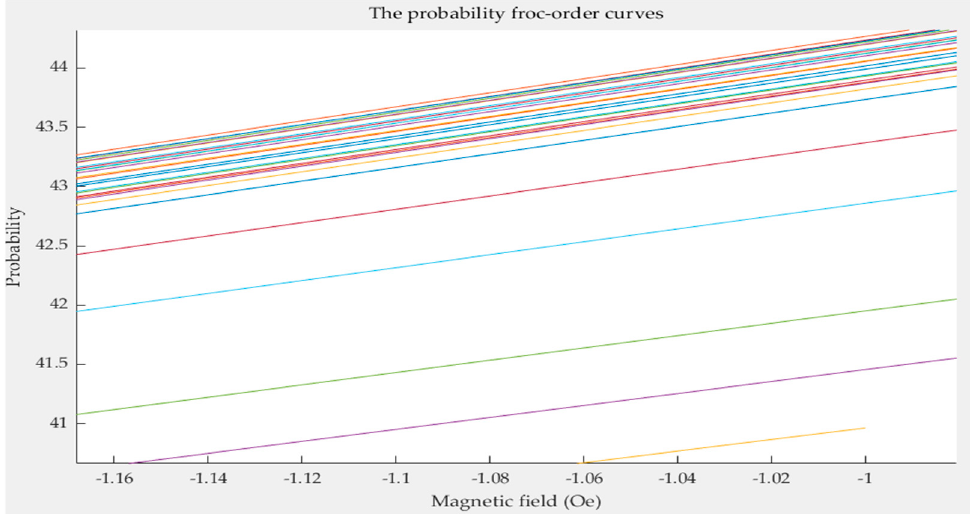
Figure 10. A partial enlarged view of the first-order curves.